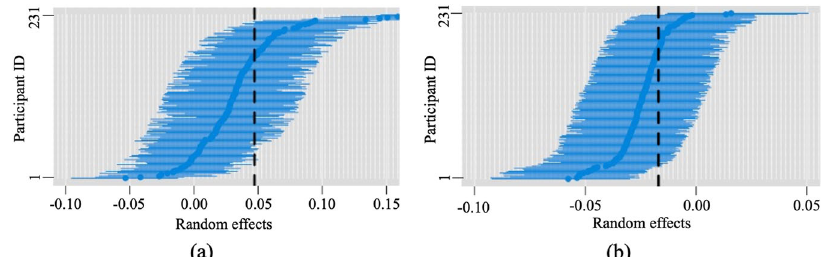
Fig. 2 Caterpillar plots of posterior estimates of varying coef fi cients of sound level and their 60% credible interval in the empirical Bayes model. The vertical dashed line is the fi xed effect coef fi cient while the horizontal blue lines indicate the random effects of sound level on physiological wellbeing across participants. a Caterpillar plot for sound level <50 dBA, and b the plot for sound level > = 50 dBA.